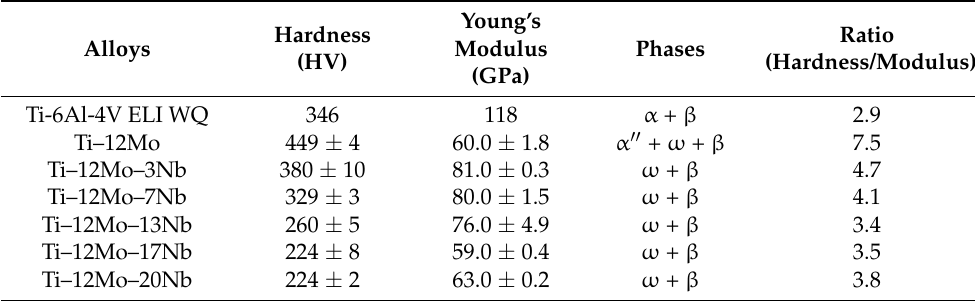
Table 1. Properties and phases of Ti–12Mo–xNb alloys treated at 950 ◦ C/1 h and, for comparison, solubilized Ti–6Al–4V ELI alloys data from